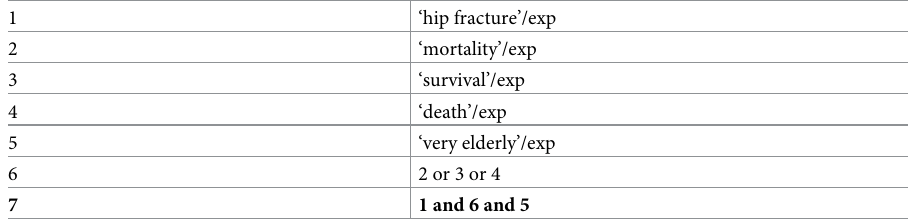
Table 2. Search strategy Embase.